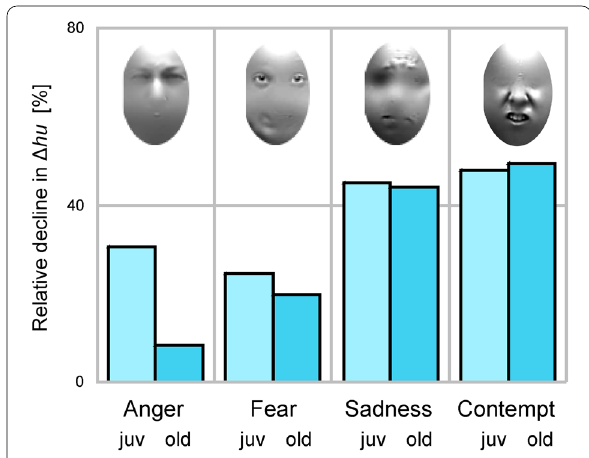
Fig. 4 Relative decline due to face masks in unbiased hit rates for each emotion. Inserts show the facial features most often used by participants to decode each emotion , adapted with permisssion from Smith et al. 2005 (the right most insert shows features used to decode disgust). juv, young cohort; old, old